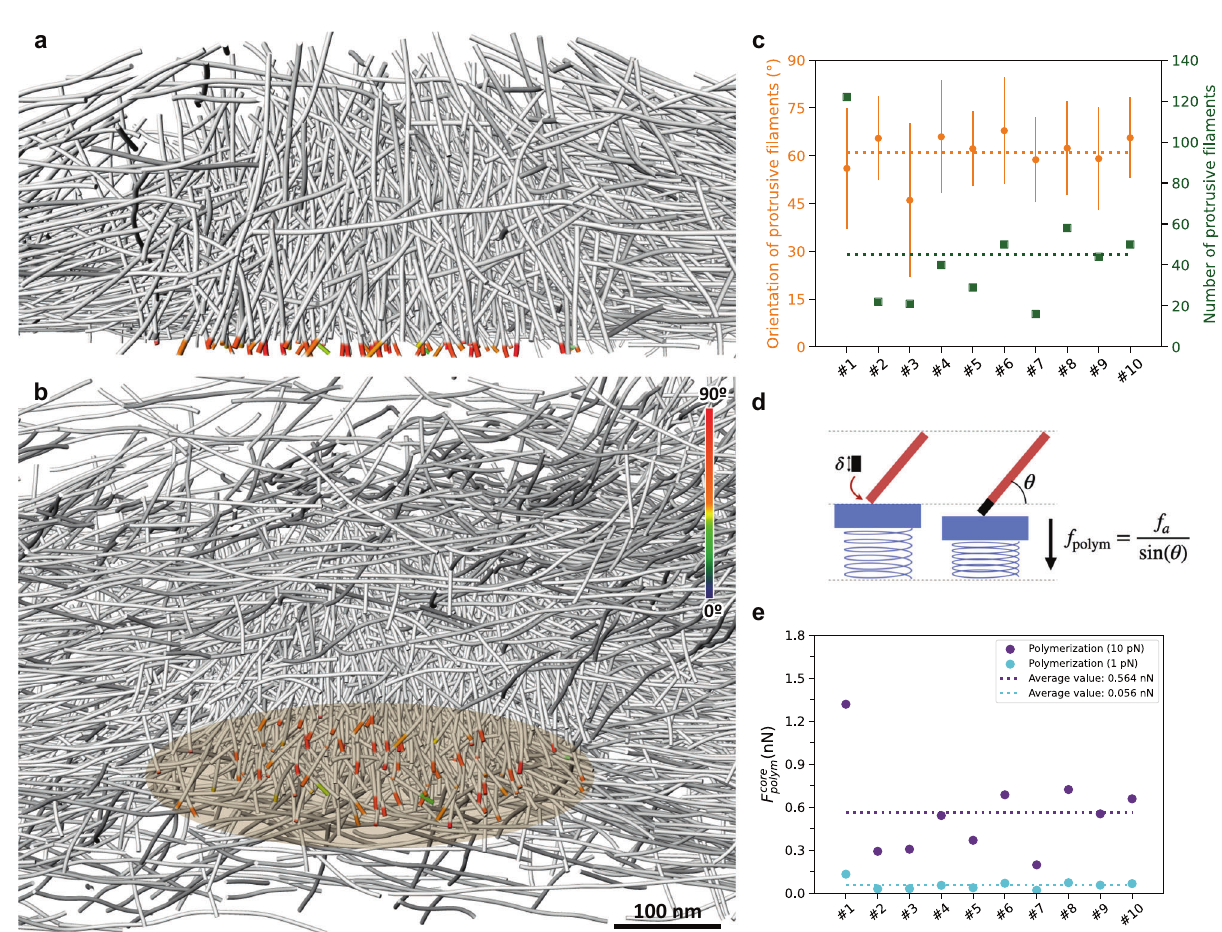
Fig. 2 The sum of the actin polymerization forces at the core membrane is below 1 nN. a , b Perspective view ( a ) of a cross-section through podosome #8 displaying in color the part of the core fi laments pushing against the plasma membrane, and orthographic view ( b ) of the same podosome from a different angle. The color map corresponds to the fi lament segment orientation with respect to the basal membrane. See also Supplementary Movie 5. The core diameter is approximately 400 nm. The original tomogram has been deposited in the EMDB under accession code EMD-13669. c Mean orientation (orange) and number (green) of polymerizing fi laments at the core membrane. Data are presented as mean values + / – SD. At least 16 fi laments were measured by tomogram. d Scheme representing the polymerization force f polym generated by the addition of a new monomer at the growing end of a fi lament with an inclination θ relative to the membrane. e Estimated polymerization force generated at the core membrane ( “ Polymerization ” ) using the lower ( “ 1 pN ” ; cyan fi lled circles) and upper ( “ 10 pN ” ; purple fi lled circles) limit of the stall force, and respective average values (dotted lines of the same color). Source data are provided as Source Data fi